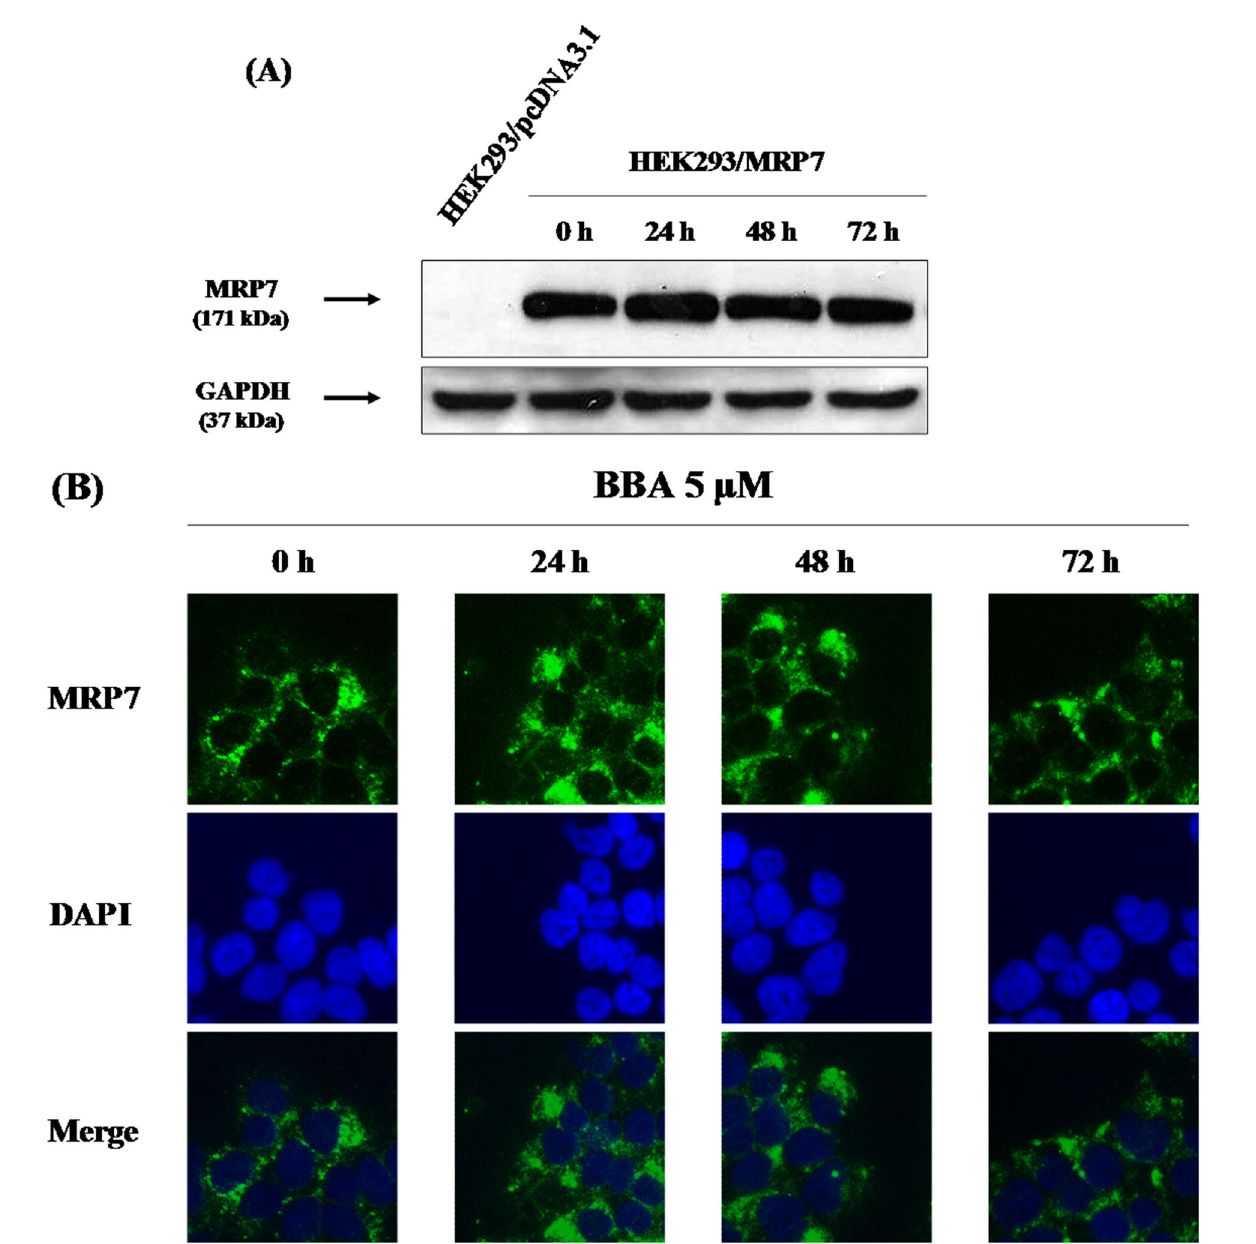
Figure 7. BBA does not affect the intracellular ATP levels in HEK293/MRP7 cells. HEK293/MRP7 cells were incubated with or without BBA at 1.25, 2.5 and 5 µM for 72 h. The intracellular ATP levels were measured as described in materials and methods. Data points represent the mean ± SD of triplicate determinations. Experiments were performed at least three independent times.